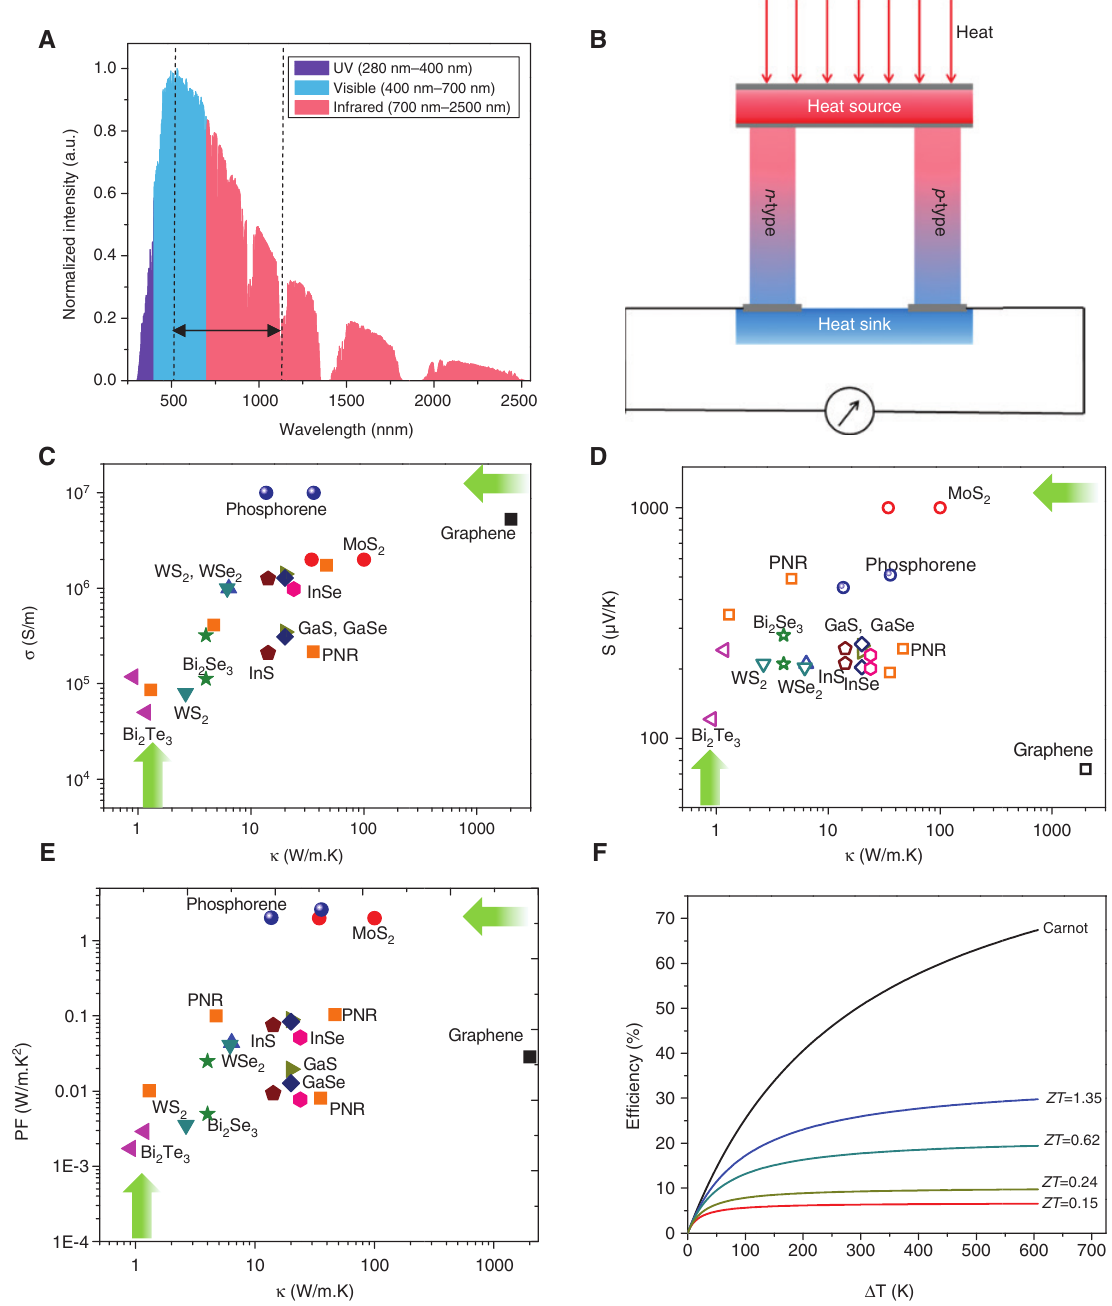
Figure 7: (A) Solar spectrum vs. wavelength. The region between the dashed lines is where most low-dimensional devices discussed in this article can cover. (B) Schematic illustration of the thermoelectric power generator. The contrast in the temperature between the top and the bottom of the thermoelectric material results in current generation, which is detected by the external resistor. (C) Electrical conductivity, (D) Seebeck coefficient, and (E) power factor at different thermal conductivities for several 2D materials obtained from the literature. The arrows indicate the desired area where a good thermoelectric materials should fall in. (F) Estimated conversion efficiency of some of the 2D materials discussed in Table 1. For an ideal thermoelectric device, the maximum attained efficiency should reach the Carnot efficiency (black curve).